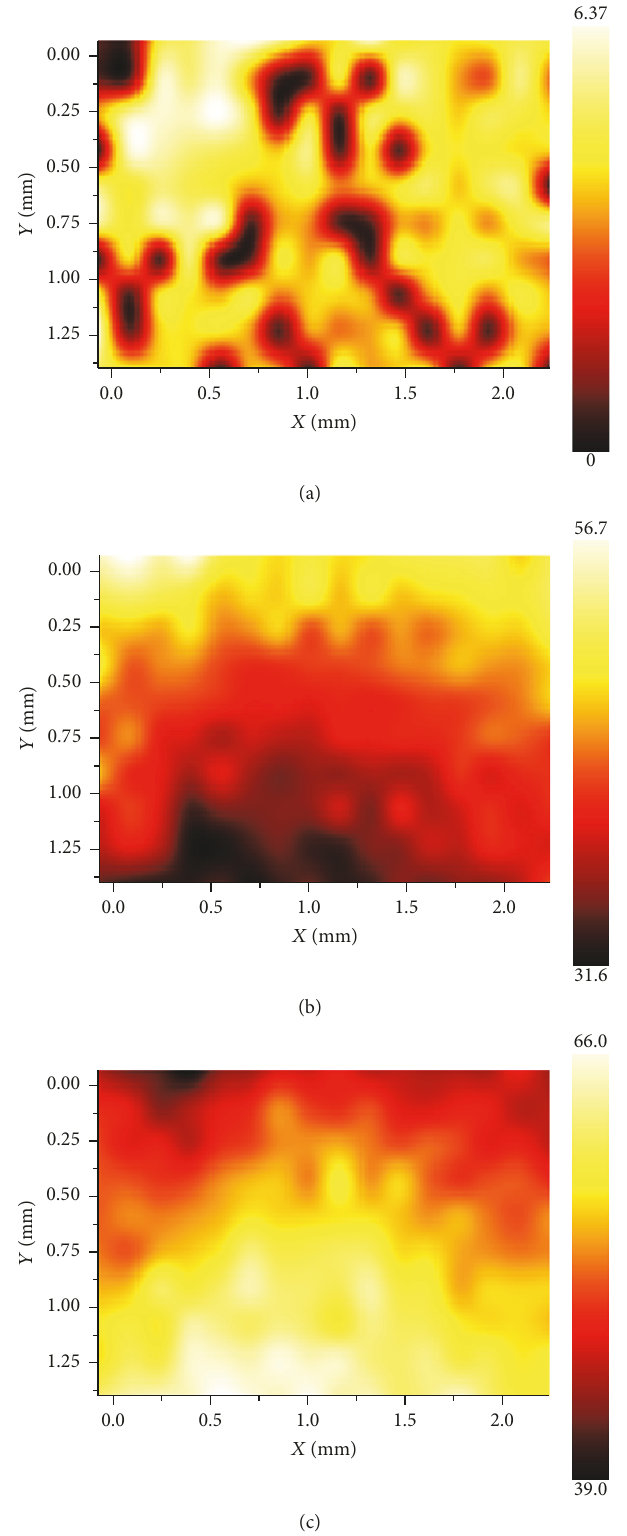
Figure 13: XPS maps for the atomic percentages of (a) Al2p; (b) O1s; and (c) Mg1s for the AZ91D alloy immersed for 1 minute in 3.5 wt.% NaCl solution at room